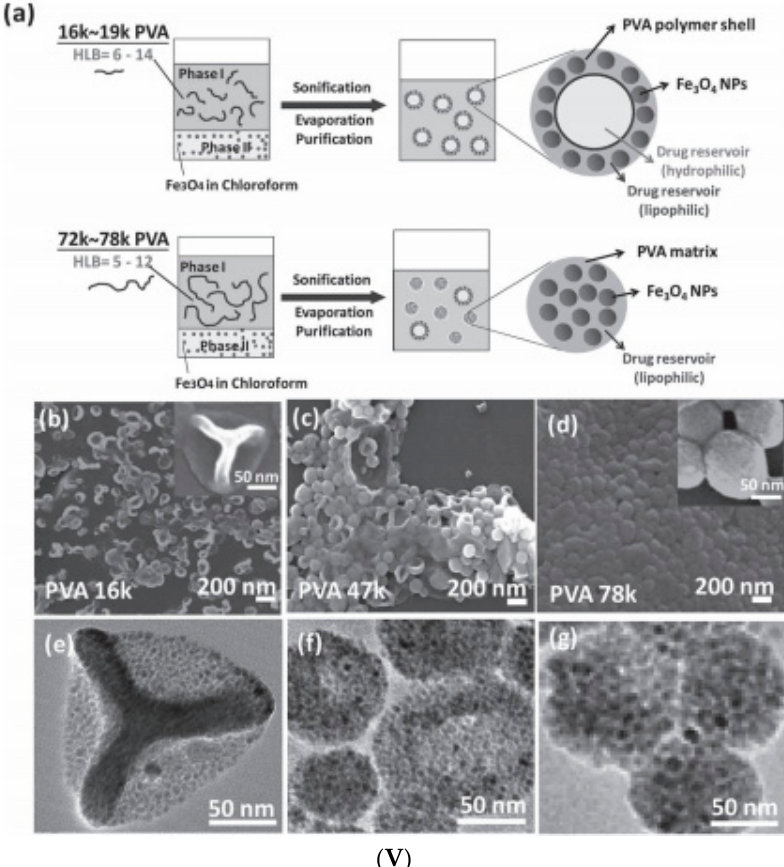
Figure 1. Magnetic nanoclusters prepared by emulsion procedures. ( I ) Preparation of clusters of magnetic nanoparticles: schematic of the oil-in-water miniemulsion procedure using hexane (or toluene)-based ferrofluid (Reprinted with permission from [122]. Copyright 2010 American Chemical Society); ( II ) Magnetic nanoparticle clusters stabilized with SDS: ( a ) TEM image (the scale bar is 200 nm); ( b ) the diameter distribution. ( c ) HRTEM image of magnetic clusters coated with polyacrylic acid; ( d ) HRTEM image of magnetic clusters coated with pNIPA (poly(N-isopropylacrylamide)–pAA